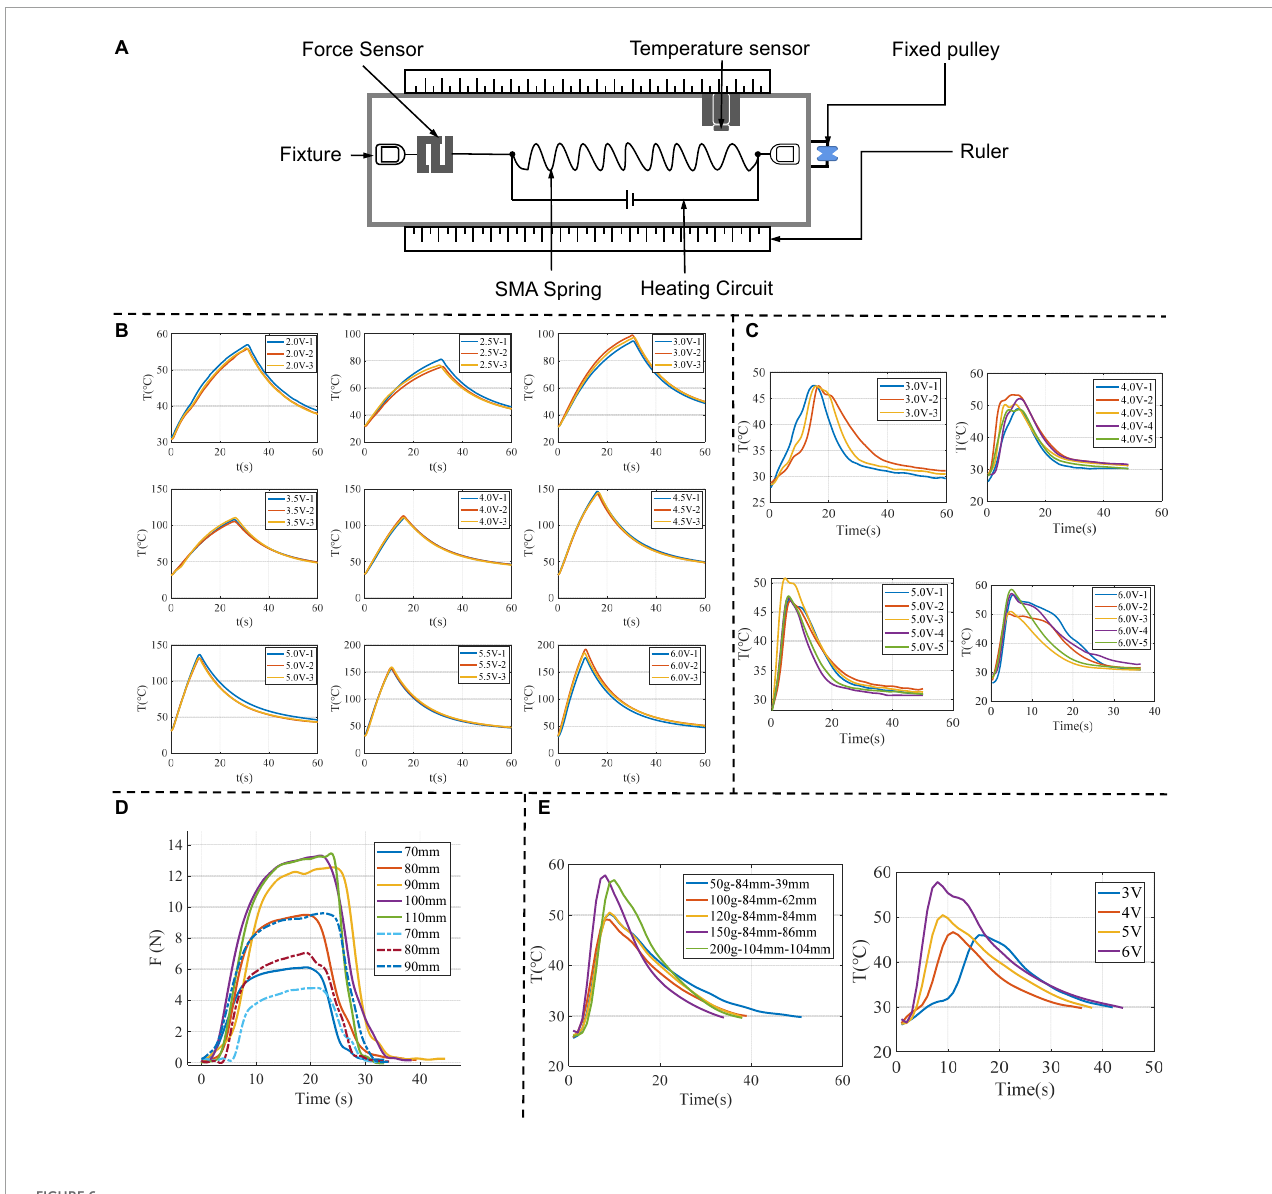
FIGURE6 Performance test of SMA springs. (A) The performance test platform; (B) temperature variation of SMA springs driven by different voltages; (C) the results of repeated experiments of TSL under different voltages; (D) the experimental results for SMA springs with different pre-tensile lengths; (E) the results of experiments of load, the left figure shows the temperature change of different loads under the same voltage (5 V), and the right figure shows the temperature and time change of different voltages under the same load (120 g).